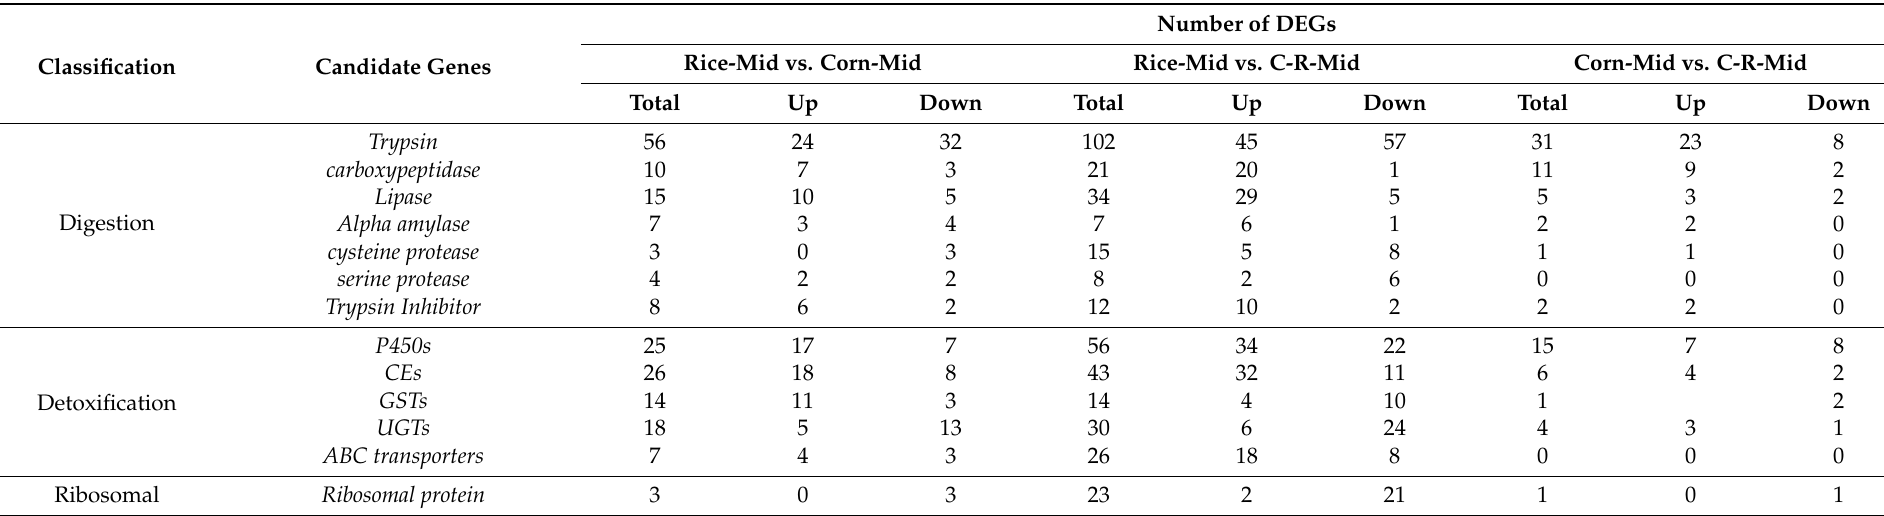
Table 2. Summary of candidate differentially expressed genes related to digestion, detoxification and ribosome in Spodoptera frugiperda midgut transcriptome differentially expressed genes (log2(FC) ≥ 1, FDR < 0.05) from pairwise comparisons among the three populations of Spodoptera frugiperda . The Corn-midgut vs. C-R-Midgut, Rice-midgut vs. C-R-Midgut and Rice-midgut vs. Corn-Midgut.